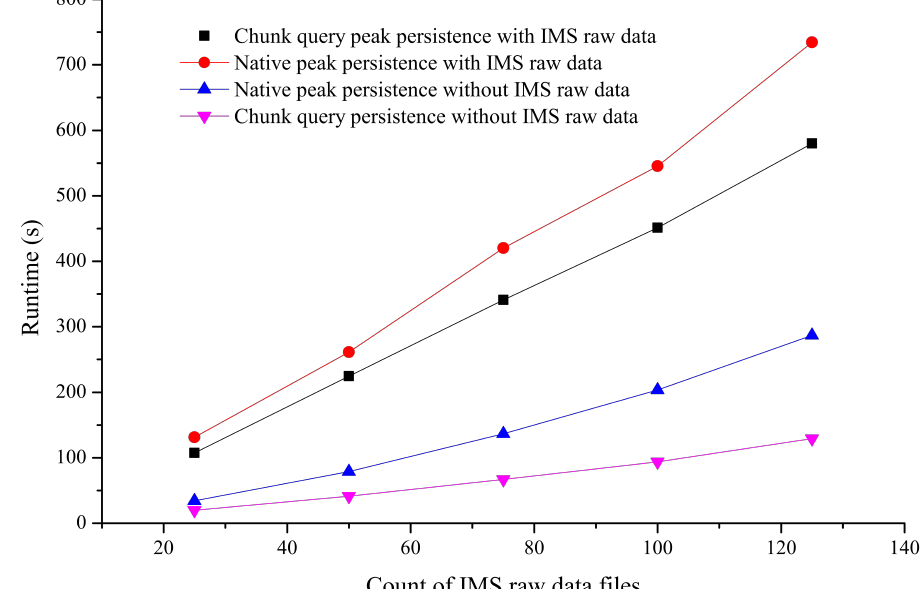
Figure 3: Report of average running times determined from ten runs of the uploading process based on five datasets with increasing number of IMS measurement files which are associated with data about 120 peak regions for each IMS measurement file respectively. Four different uploading strategies are shown. The two methods CQPP (black line, pink line) and native peak persistence (red line, blue line) are thereby combined with the options of storing the IMS raw data measurement files into the